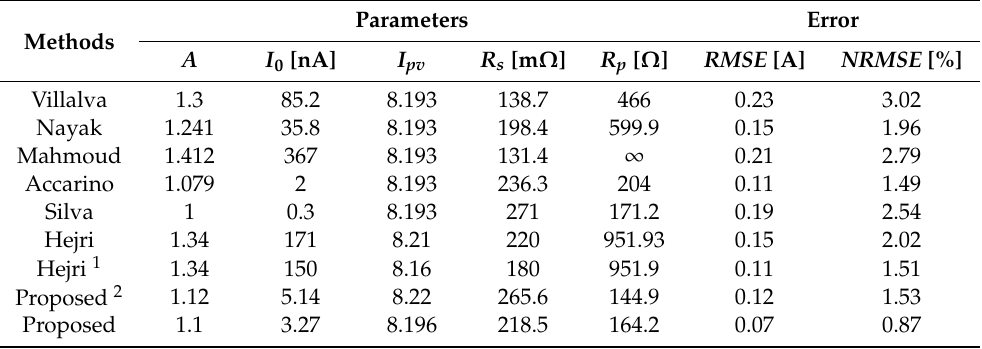
1 Curve fitting method. 2 Datasheet table